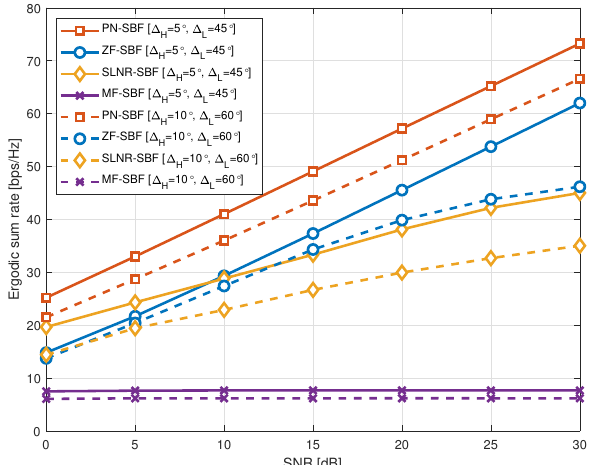
Figure 1. Ergodic sum rate of the statistical beamforming (SBF) schemes according to the spatial correlation, where M = 128, K H = 5, and K L =